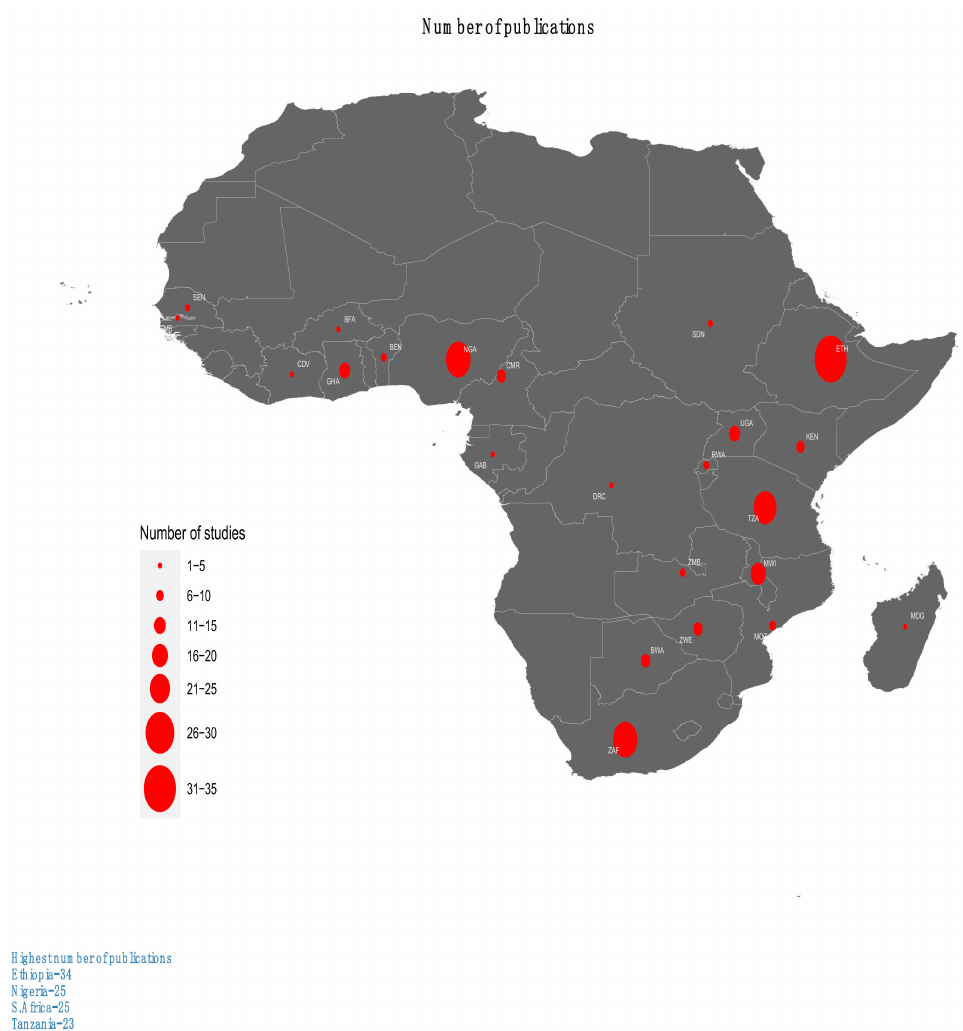
Figure 2. Geographical distribution of the included